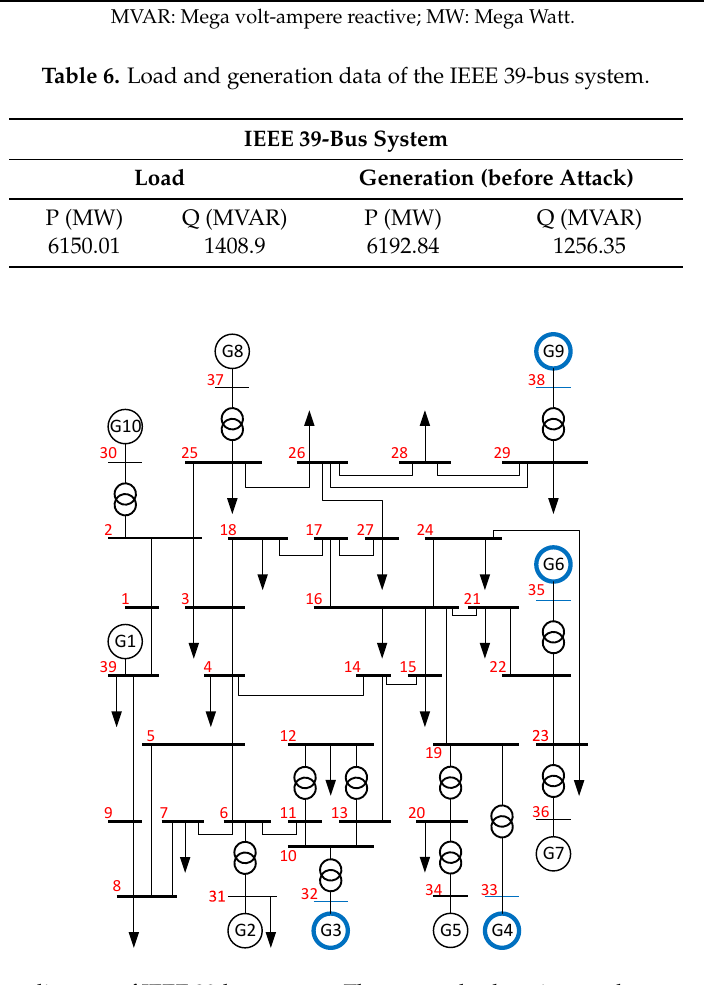
Figure 6. One-line diagram of IEEE 39-bus system. The targeted substations and generators are marked in